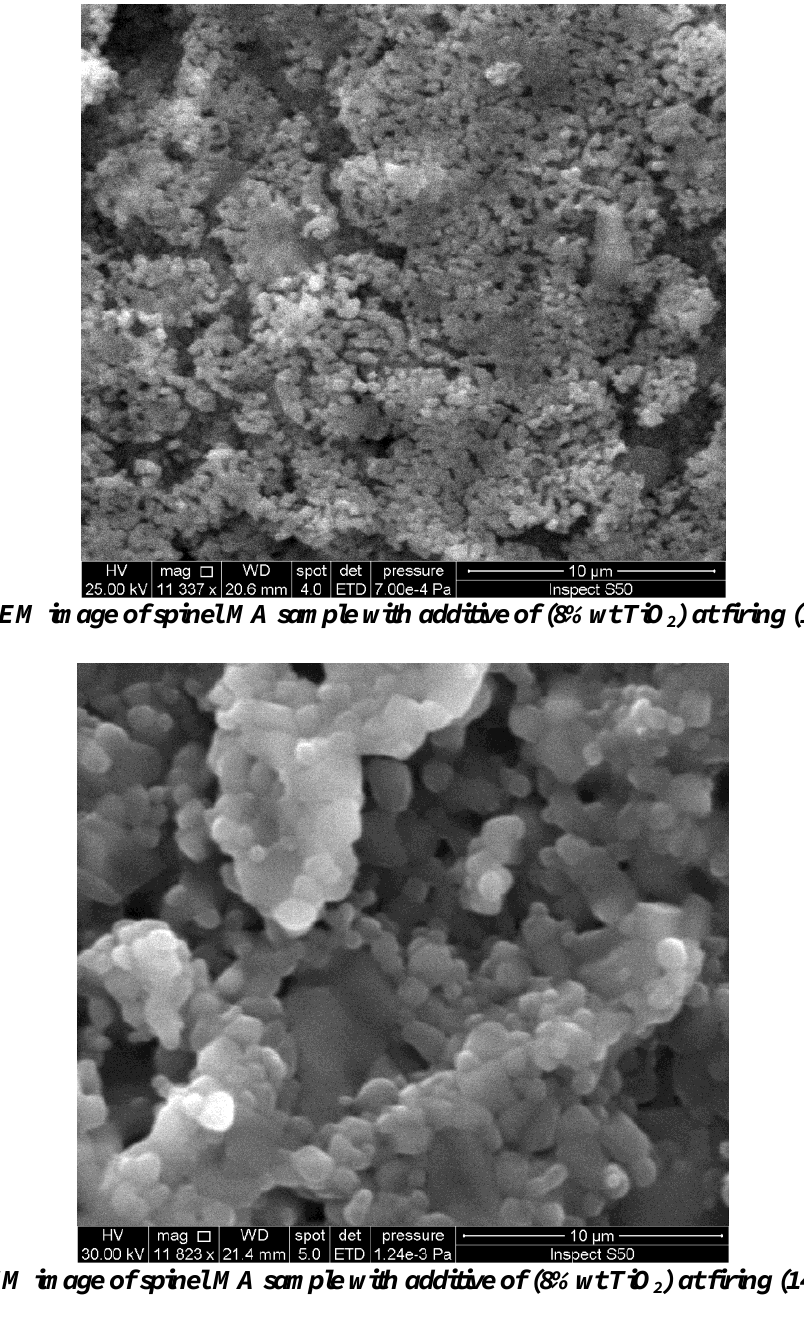
Fig. 4: SEM image of spinel MA sample with additive of (8%wt TiO